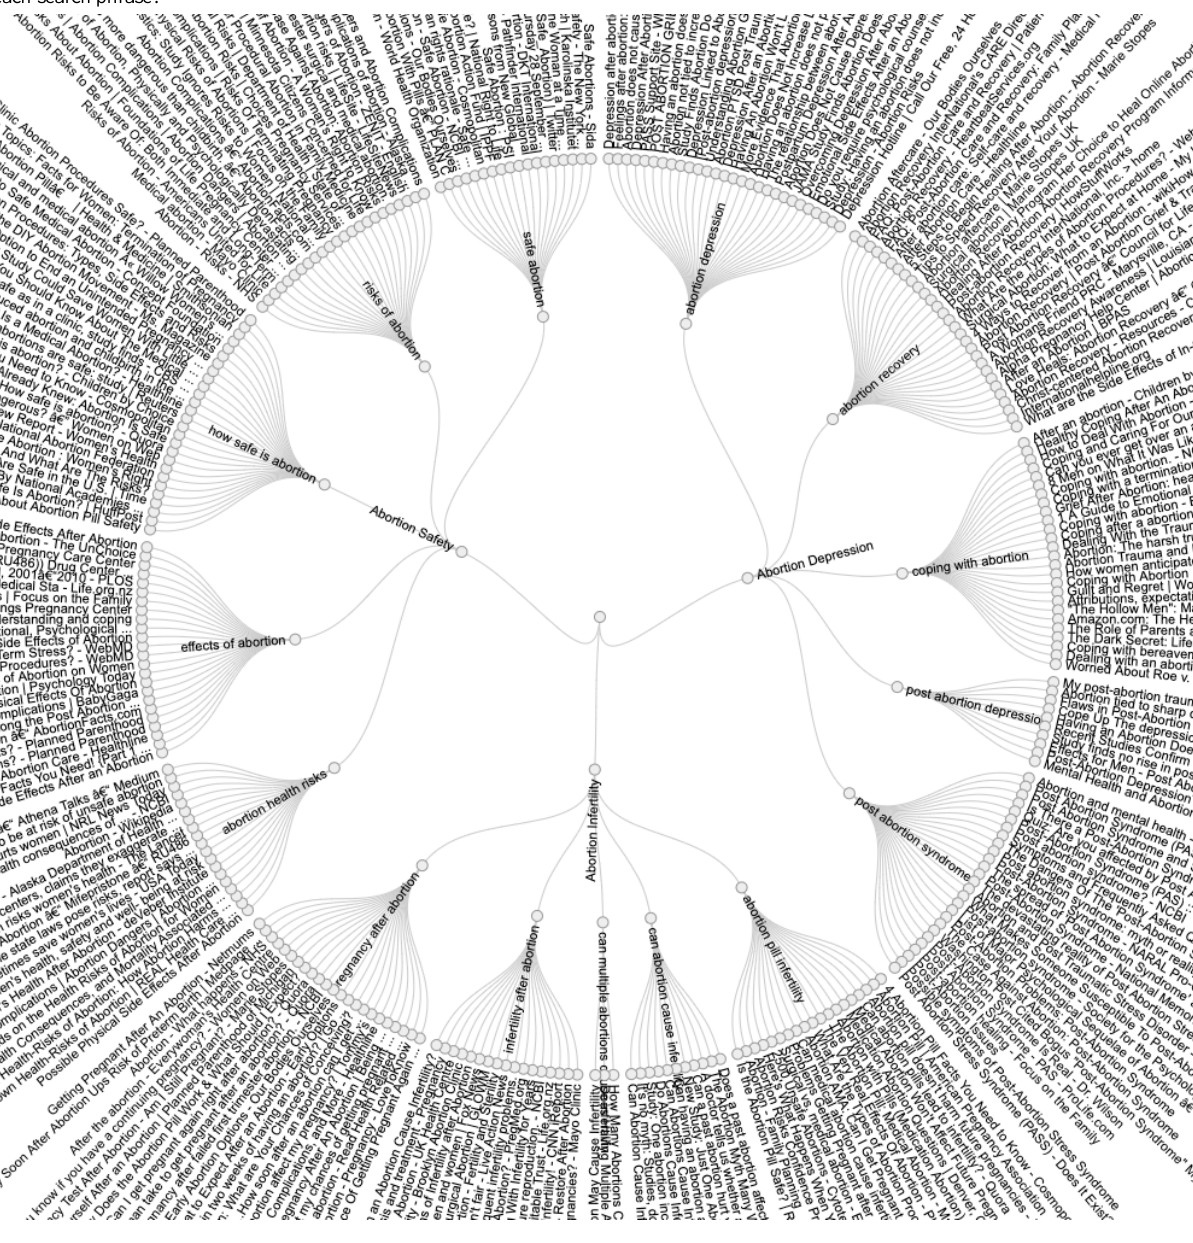
Figure 2. Circular dendrogram of unique websites found in the analysis. The center depicts the 3 keywords used to identify the most commonly searched terms for those topics, the middle ring includes the search phrases that were used for the Google search, and the outer ring depicts the URL search results for each search